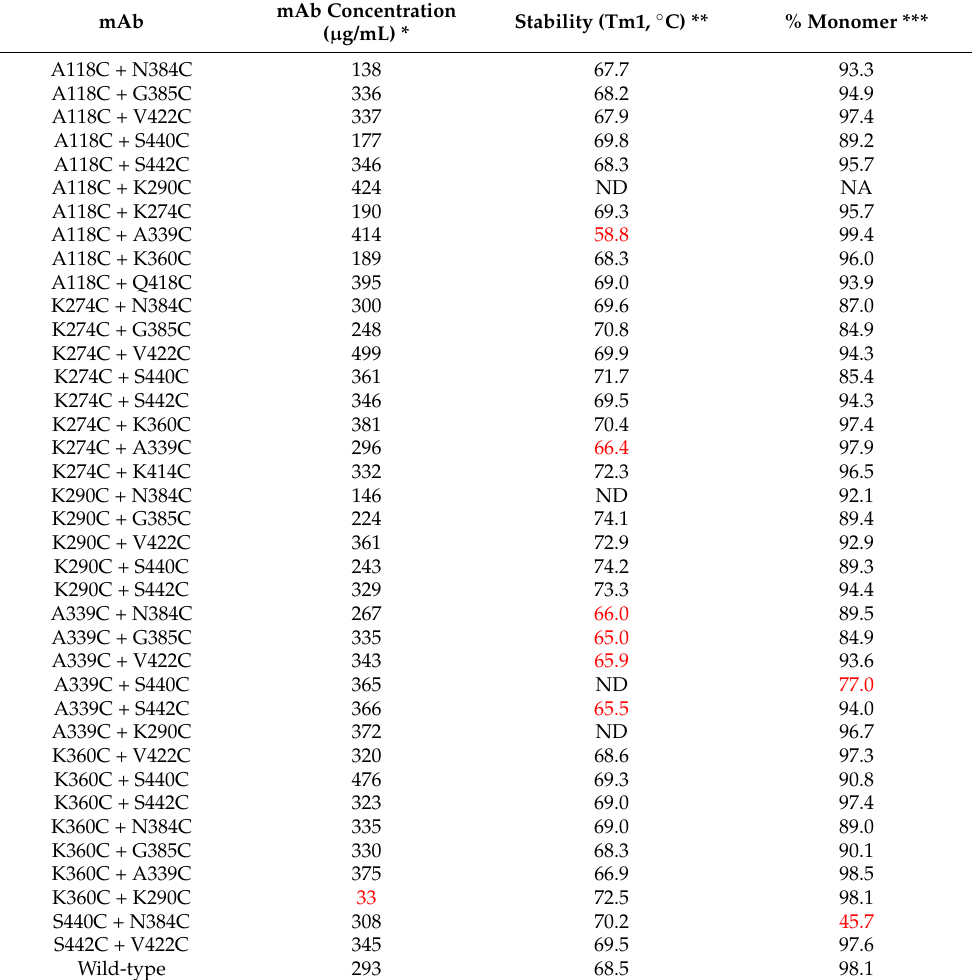
Table 2. Characterization of engineered double cysteine